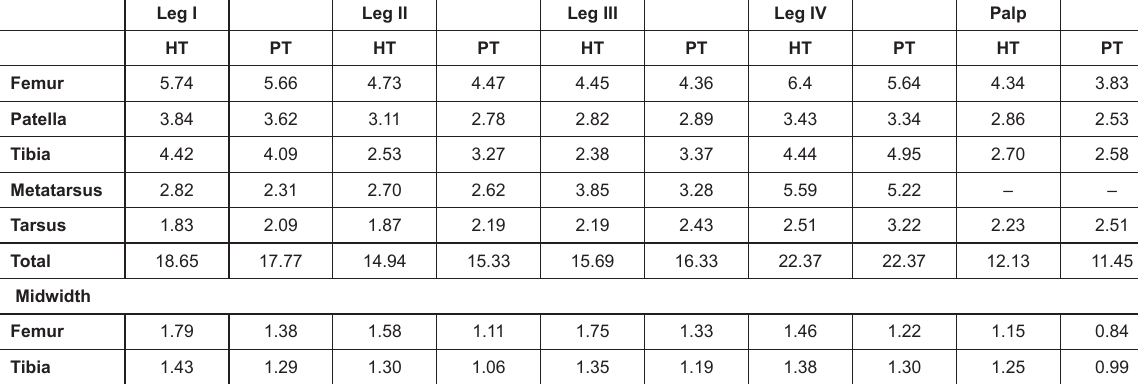
Table 4. Neoheterophrictus uttarakannada sp. nov., measurements of legs and palp of holotype (WILD–10–ARA–923), paratype (WILD–10–ARA–672) Leg